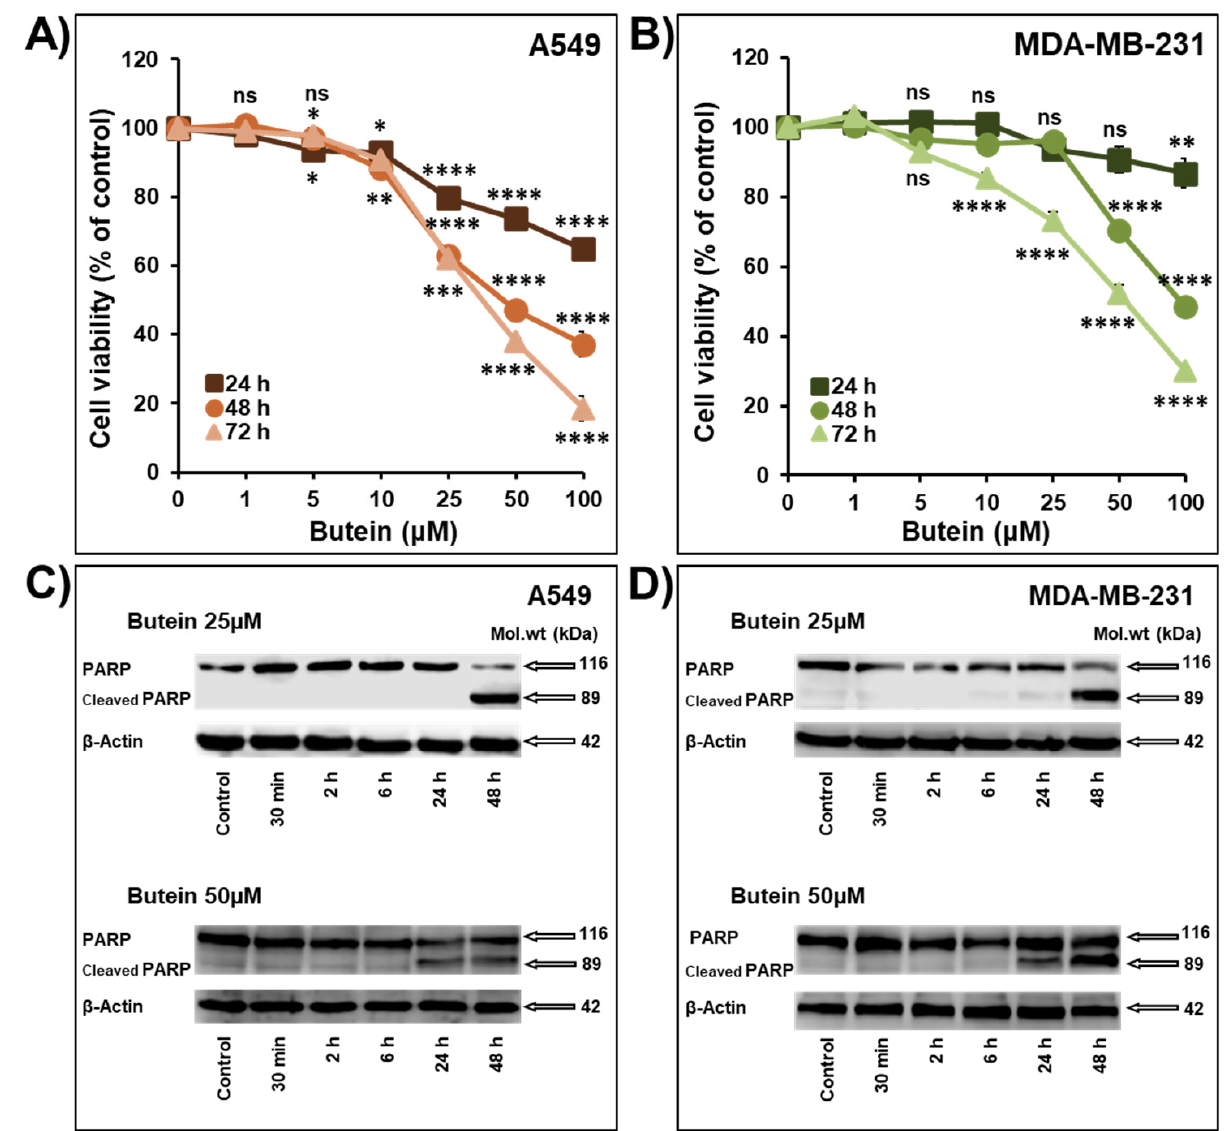
Figure 1. Inhibition of cellular viability associated PARP cleavage by butein. Exponentially growing A549 ( A ) and MDA-MB-231 ( B ) cells were treated with vehicle (0.1% DMSO) and the indicated concentrations of butein for 24, 48, and 72 h. Viable cells were determined using the CellTiter-Glo Luminescent Cell Viability Assay, based on ATP quantification, which indicates the presence of viable cells. Experiments were repeated at least three times. Western blot analysis shows PARP cleavage after butein (25 and 50 µ M) treatment in A549 ( C ) and MDA-MB-231 ( D ) cancer cells. β -actin was used as a loading control. The data shown are representative of three in-dependent experiments. Shapes represent means; bars represent S.E.M. * Significantly different at p < 0.05, ** Significantly different at p < 0.01, *** Significantly different at p < 0.001, **** Significantly different at p < 0.0001. ns—non-significant. Cancer cell migration and invasion are critical steps in the process of metastasis. To de- termine whether butein inhibited cell migration and invasion in vitro, lung A549 and breast MDA-MB-231 cancer cells were treated with low concentrations of butein (5 and 10 µ M). As shown in Figure 4, butein induced a significant time- and concentration-dependent inhibition of A549 (Figure 4A) and MDA-MB-231 (Figure 4B) cancer cell migration.